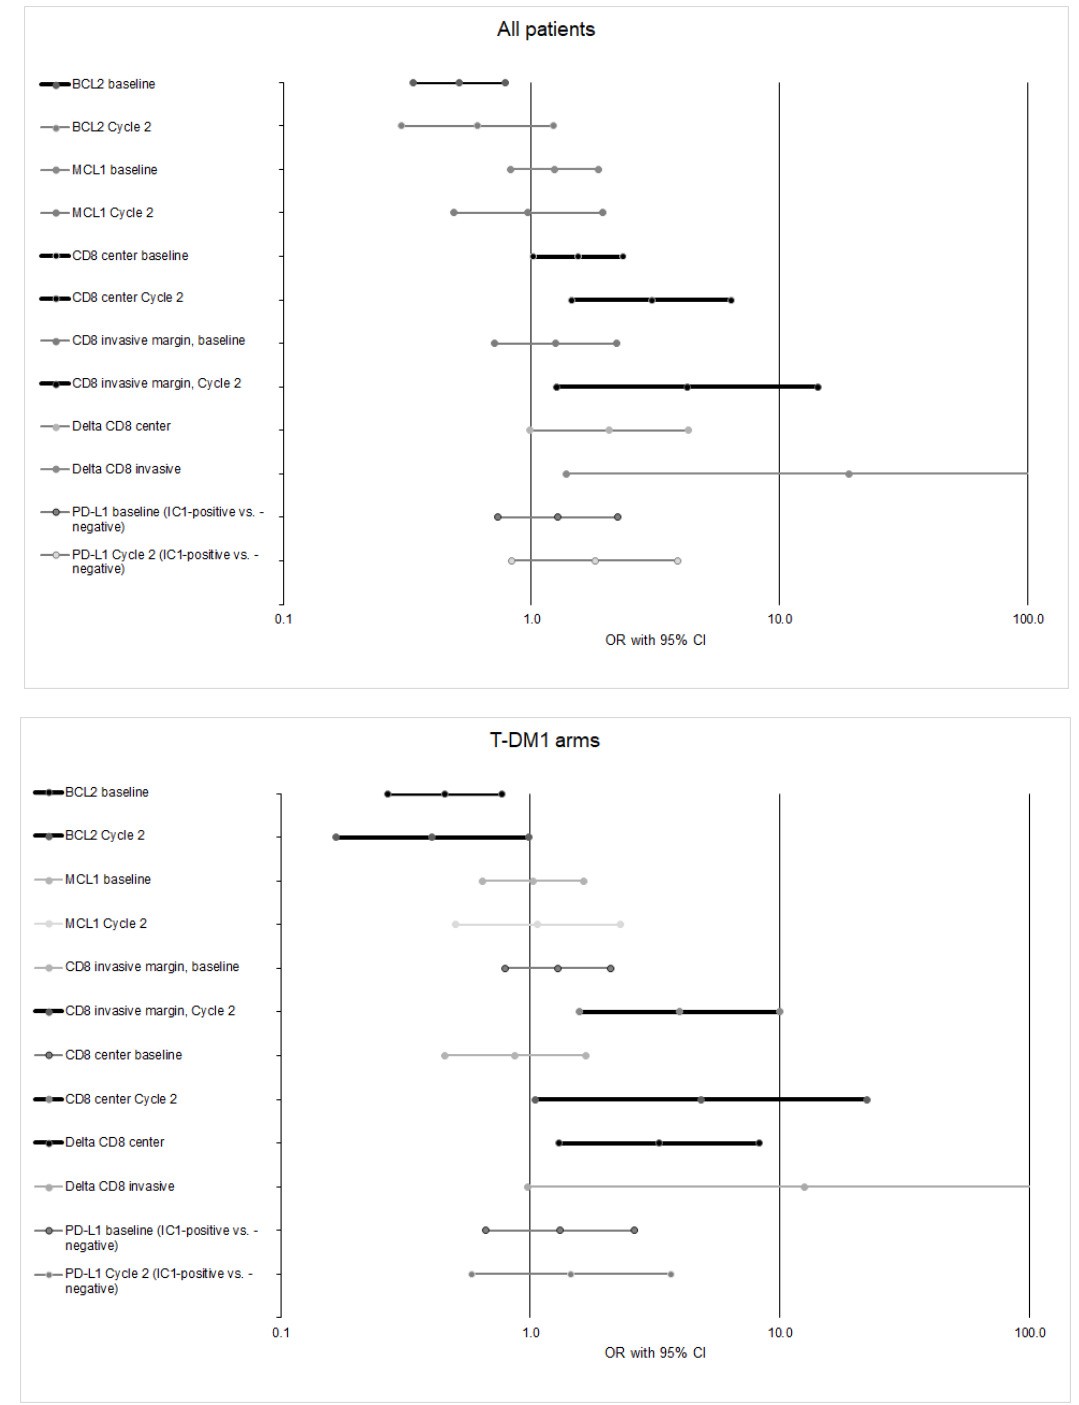
Figure 2. Unadjusted ORs of biomarkers at baseline and Cycle 2 for pCR in all patients ( top panel) and in T-DM1 arms combined ( bottom panel). All ORs are expressed as an interquartile ratio unless otherwise indicated (i.e., for PD-L1–IC). “Favorable” markers are those with OR >1. CNT, center; IC, immune cells; IC1, IHC staining in ≥ 1% and <5% of IC; INV, invasive margin; LCL, lower confidence limit; OR, odds ratio; PD-L1, programmed death-ligand 1; T-DM1, ado-trastuzumab emtansine; UCL, upper confidence limit.